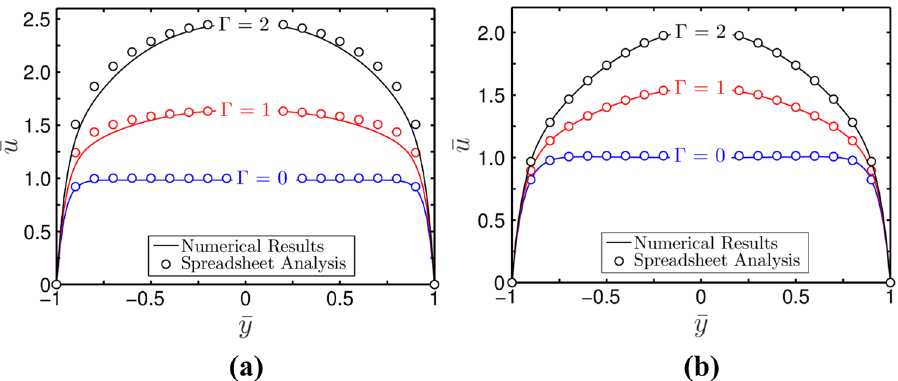
Figure 8. Plots depict velocity profile for different values of Ŵ at z = 0 . The other parameters are taken as κ = 20 for ( a ) n = 0.8 and ( b ) n = 1.2 . The MATLAB solutions are represented by solid lines, whereas the spreadsheet analysis tool-derived solutions are shown by